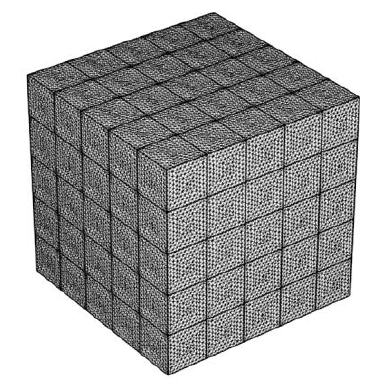
Figure 19. The typical finite element discretization used to model the cuboidal regions for modeling one-dimensional flow.